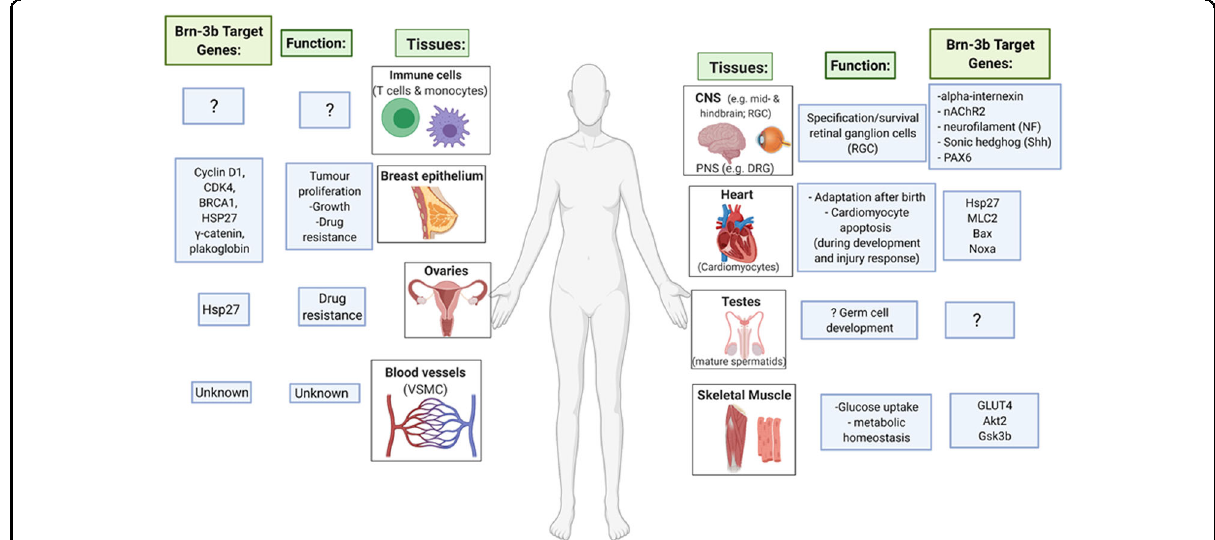
Fig. 2 Representation of different tissues that express Brn-3b. The effects of Brn-3b in different tissues and target genes, where known, are also